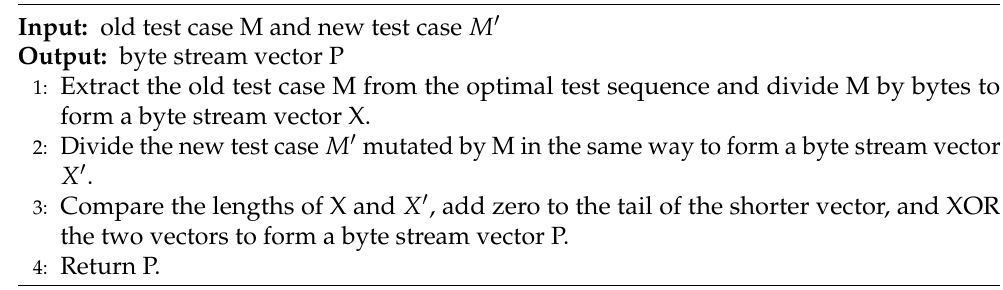
Algorithm 1 General representation of the QRNN